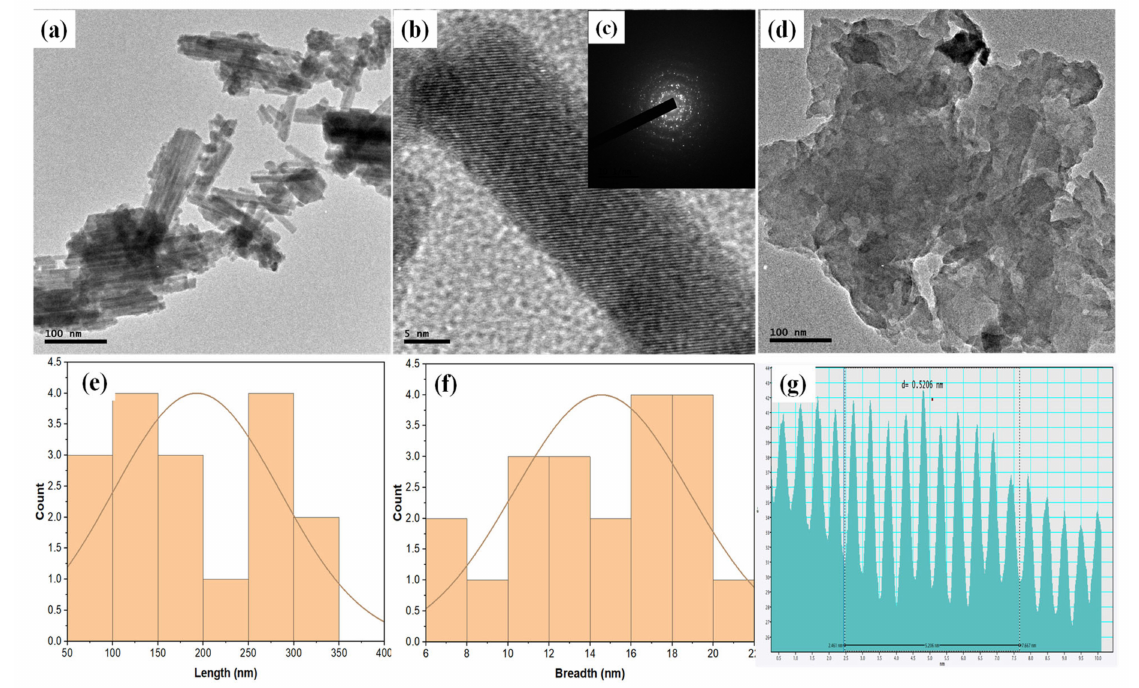
Figure 4. ( a )TEM, ( b ) HRTEM, and ( c ) SAED images of Cu 3.21 Bi 4.79 S 9 ; ( d ) TEM image of Cu 3.21 Bi 4.79 S 9 /gC 3 N 4 ; particle size distribution histogram of Cu 3.21 Bi 4.79 S 9 , showing ( e ) length, ( f ) breadth, and ( g ) is the d-spacing of the encapsulated